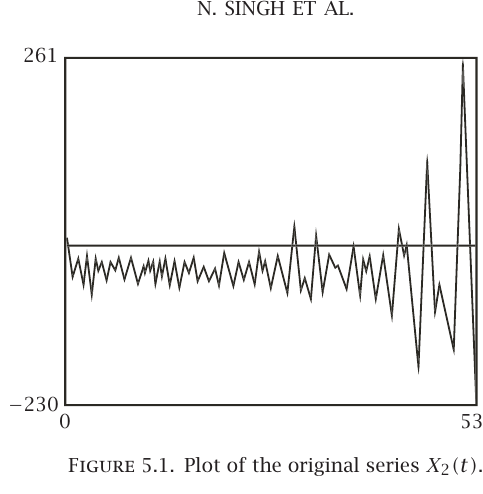
Figure 5.1 . Plot of the original series X